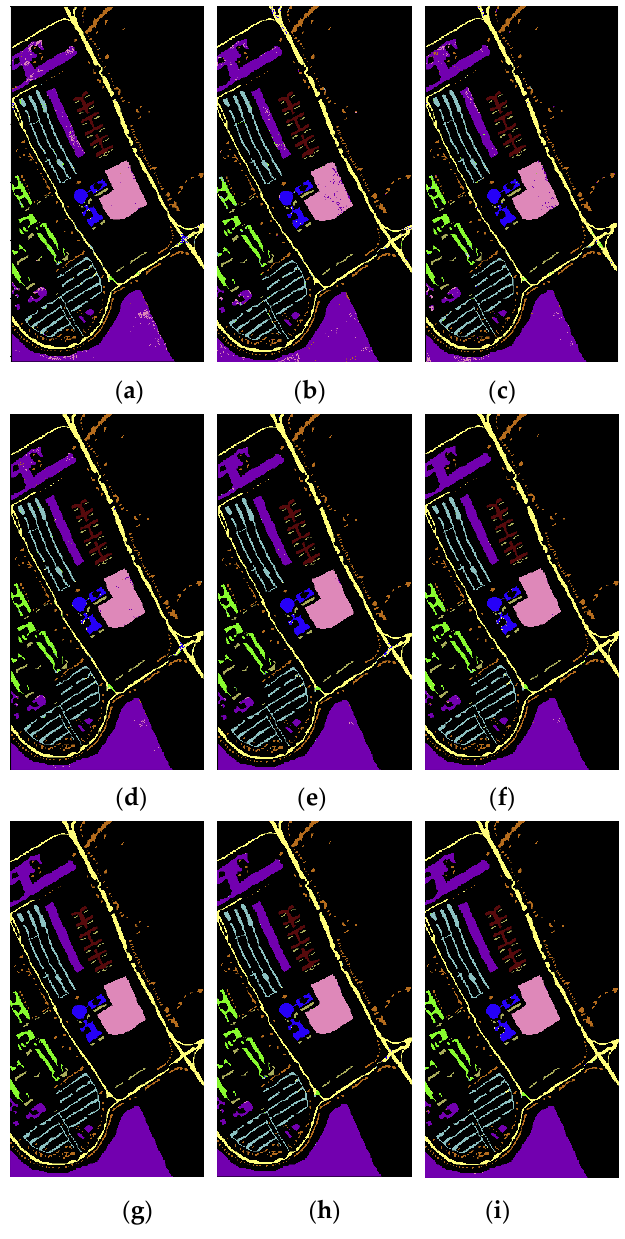
Figure 12. Classification results on the Pavia University dataset: ( a ) NDR; ( b ) IM; ( c ) IM_SPE; ( d ) NDR_MIG; ( e ) IM_MIG; ( f ) IM_SPE_MIG; ( g ) NDR_MIG_DN; ( h ) IM_MIG_DN; ( i ) IM_SPE_MIG_DN methods.